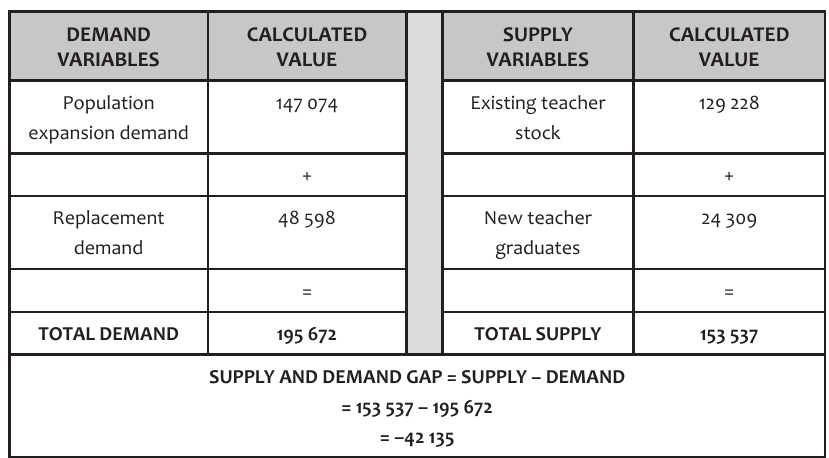
Table 6: Projected 2020 foundation phase teacher supply and demand gap, restricted to more certain